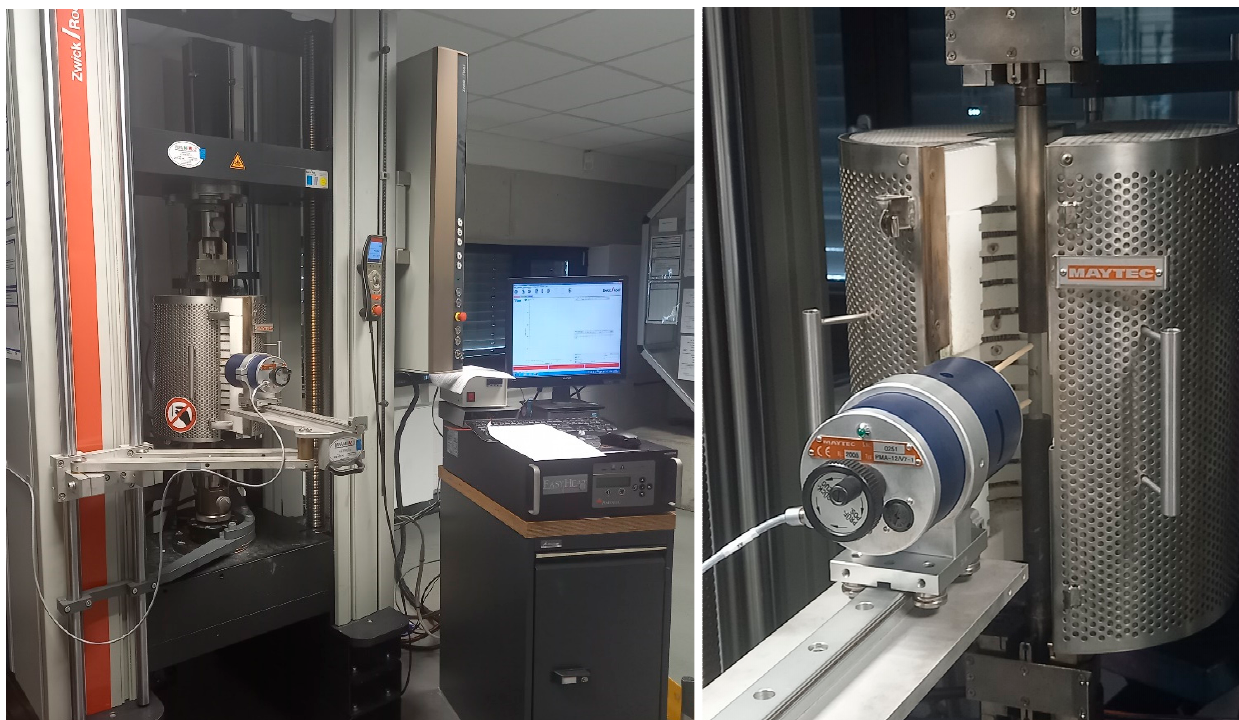
Figure 3. Test setup for high-temperature tensile tests showing sample position and furnace as well as the extensometer used for the experiments. ( Left ) Overview including part of the Zwick Roell Z250 test device, and ( right ) detailed view of the extensometer and sample.